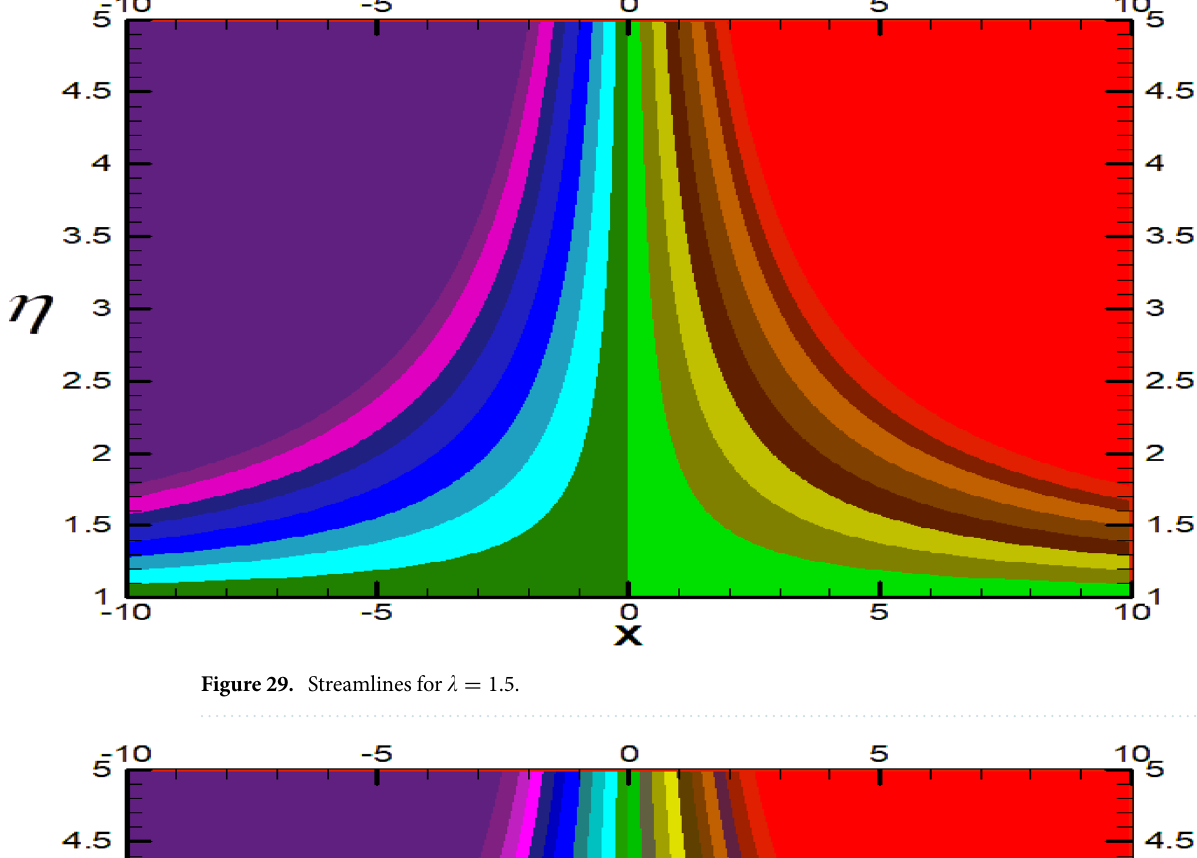
Figure 29. Streamlines for (cid:31)